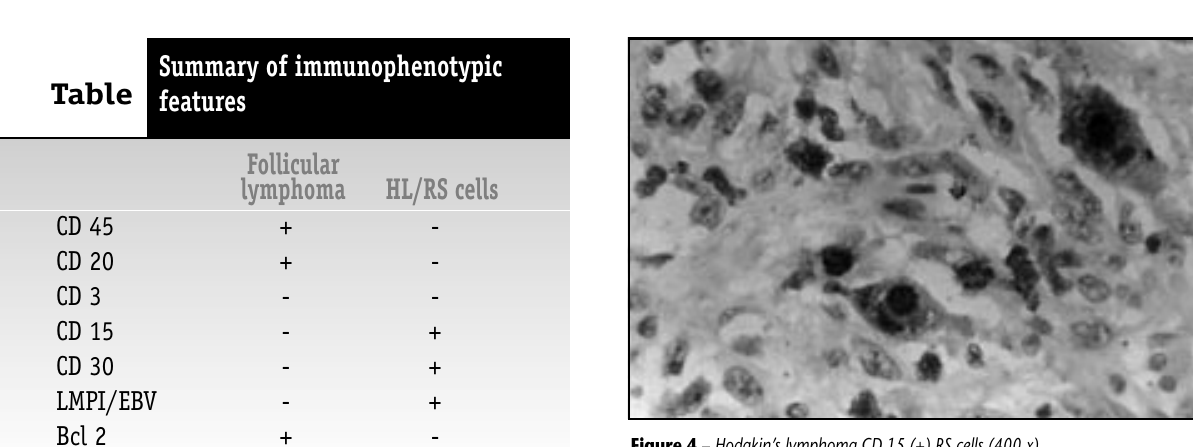
Figure 2 – A: Spleen showing white pulp infiltrated by small cell lymphoma (H&E 200 x). B: Spleen showing a mixed-cellularity Hodgkin’s lymphoma, with RS cells and variants admixed with lymphocytes (H&E 400